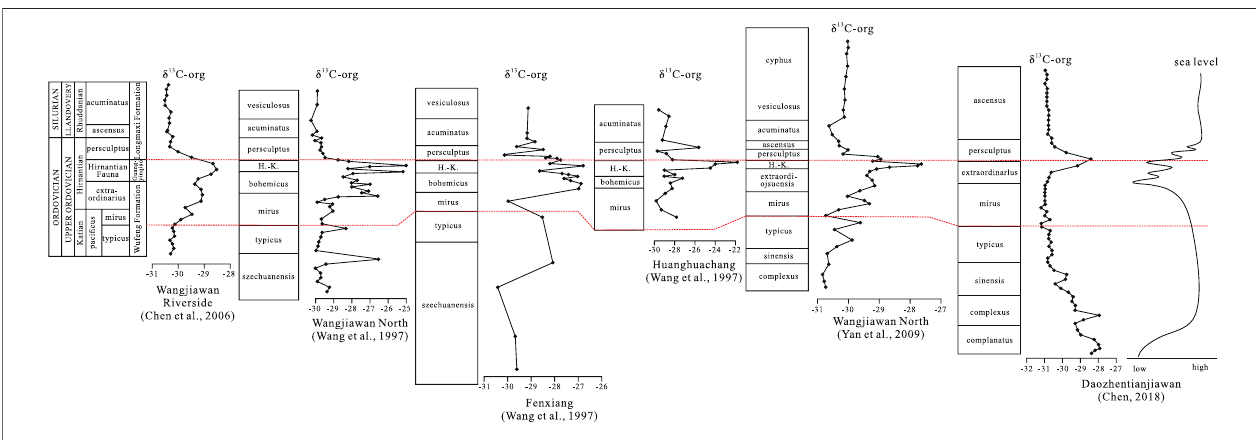
FIGURE 10 | Organic carbon isotopic curve of isolated kerogen at the Wangjiawan Riverside and North sections, Fenxiang, Huanghuachang, Nanbazi, and Tianjiawan sections in China (Wang et al., 1997; Fan et al., 2009; Yan et al., 2009; Chen, 2018). Also shown are the sea-level changes, the uppermost Ordovician systems, series stages, biozonations, and lithostratigraphic units. Modi fi ed from Fan et al. (2009).